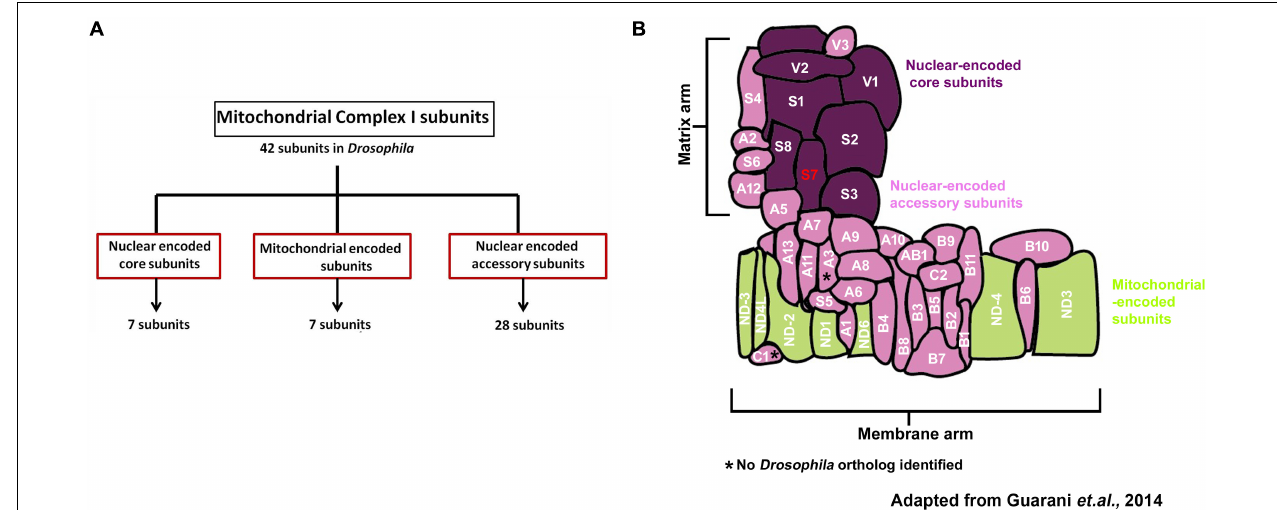
FIGURE 1 | Organization and classification of Drosophila Mitochondrial Complex I (Cl) subunits. (A) Schematic showing how Mitochondrial Complex I (MCI) is organized into three distinct classes of subunits (Nuclear-encoded core: 7 subunits, mitochondrial-encoded: 7 subunits and nuclear-encoded accessory: 28 subunits). (B) Schematic representation of how the 42 different subunits of Drosophila MCI are arranged to produce the L-shaped topology; adapted from Guarani et al. (2014). NDUFS7/S7 ( ND-20L ) is labeled in